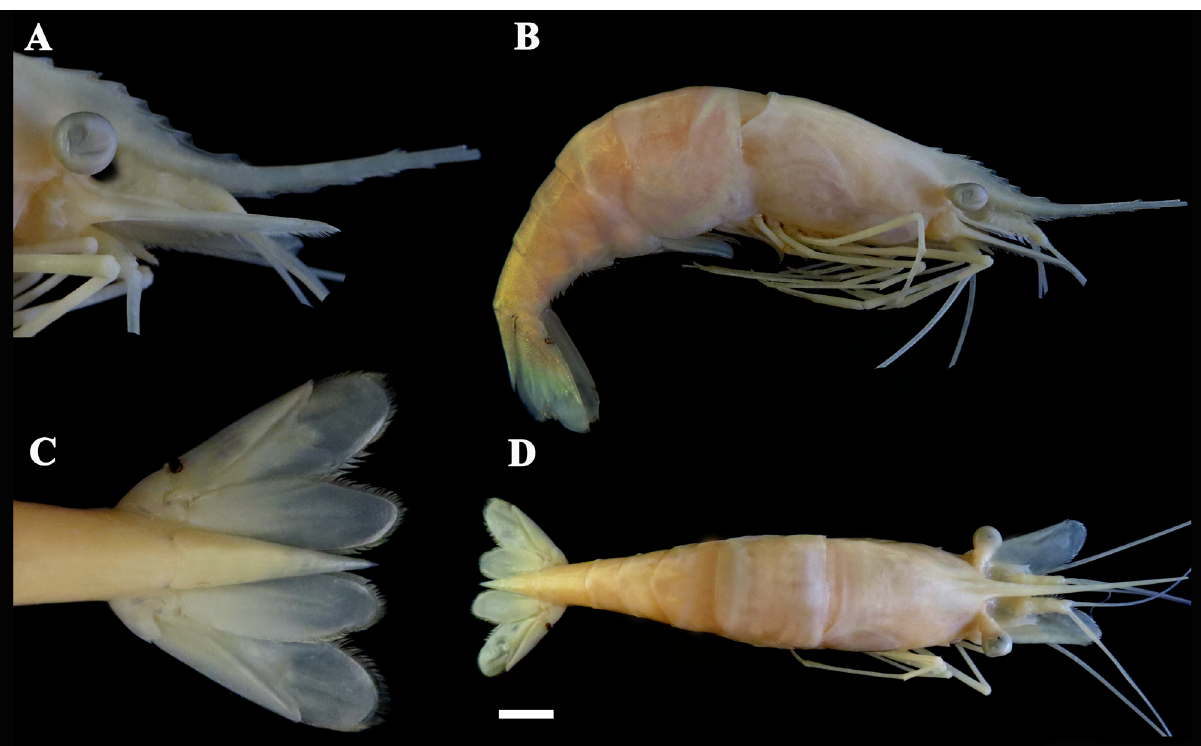
Figure 3. Macrobrachium amazonicum (Heller, 1862), male (LSZ 030). A, Detail of the anterior region of the carapace; B, habitus, lateral view; C, detail of the telson and uropods, dorsal view; D, habitus, dorsal view. Scale bar: 1 cm.